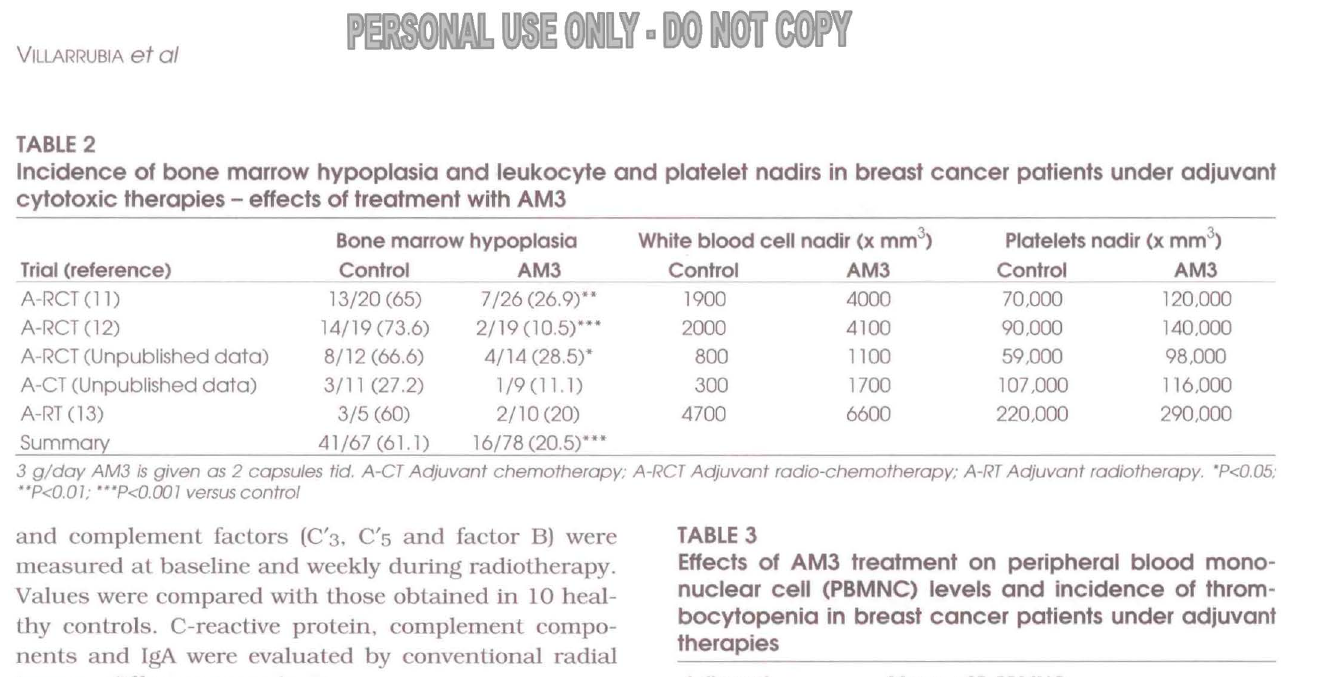
Effects of AM3 treatment on peripheral blood mono nuclear cell (PBMNC) levels and incidence of